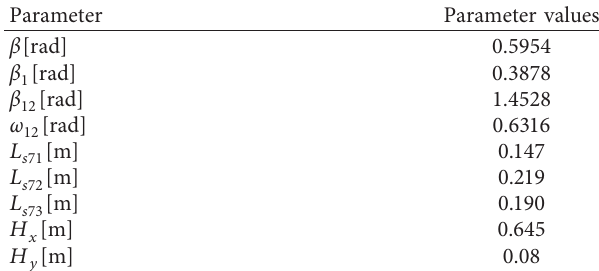
Table 2: Parameters.